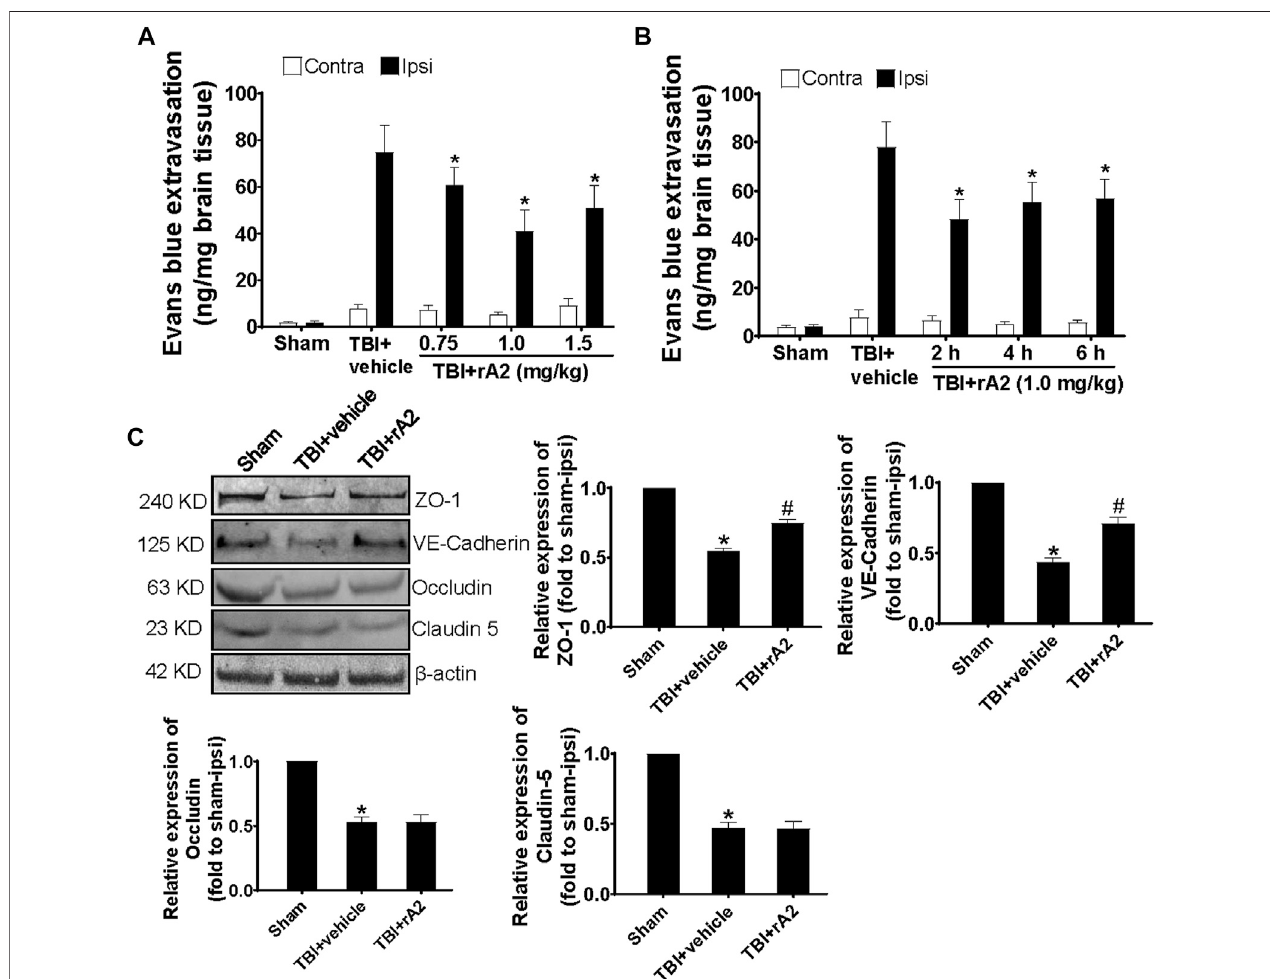
FIGURE1| rA2administrationreducesBBBleakageafterTBIinmice. (A) Dose-range(0.75,1.0,and1.5 mg/kg)effectsofrA2administrationtreatedat2 hinBBB permeability examined at 24 h after TBI. (B) The therapeutic time window of rA2 administration in BBB permeability reduction examined at 24 h after TBI, treated at 2 h, or 4 h, or 6 h after TBI, respectively. Data are expressed as mean ± SEM, n (cid:1) 8 mice per group, * p < 0.05 vs. BSA treated ipsilateral hemisphere. (C) Representative gel images of western blotting and quantitative analysis for ZO-1, VE-Cadherin, Occludin, Claudin-5 expression in the ipsilateral hemispheres collected at 24 h after TBI. β -actin was used as the equal loading control. Data are expressed as mean ± SEM, n (cid:1) 4 mice per group, * p < 0.05 vs. Sham, # p < 0.05 vs. TBI+vehicle (1 mg/kg BSA).